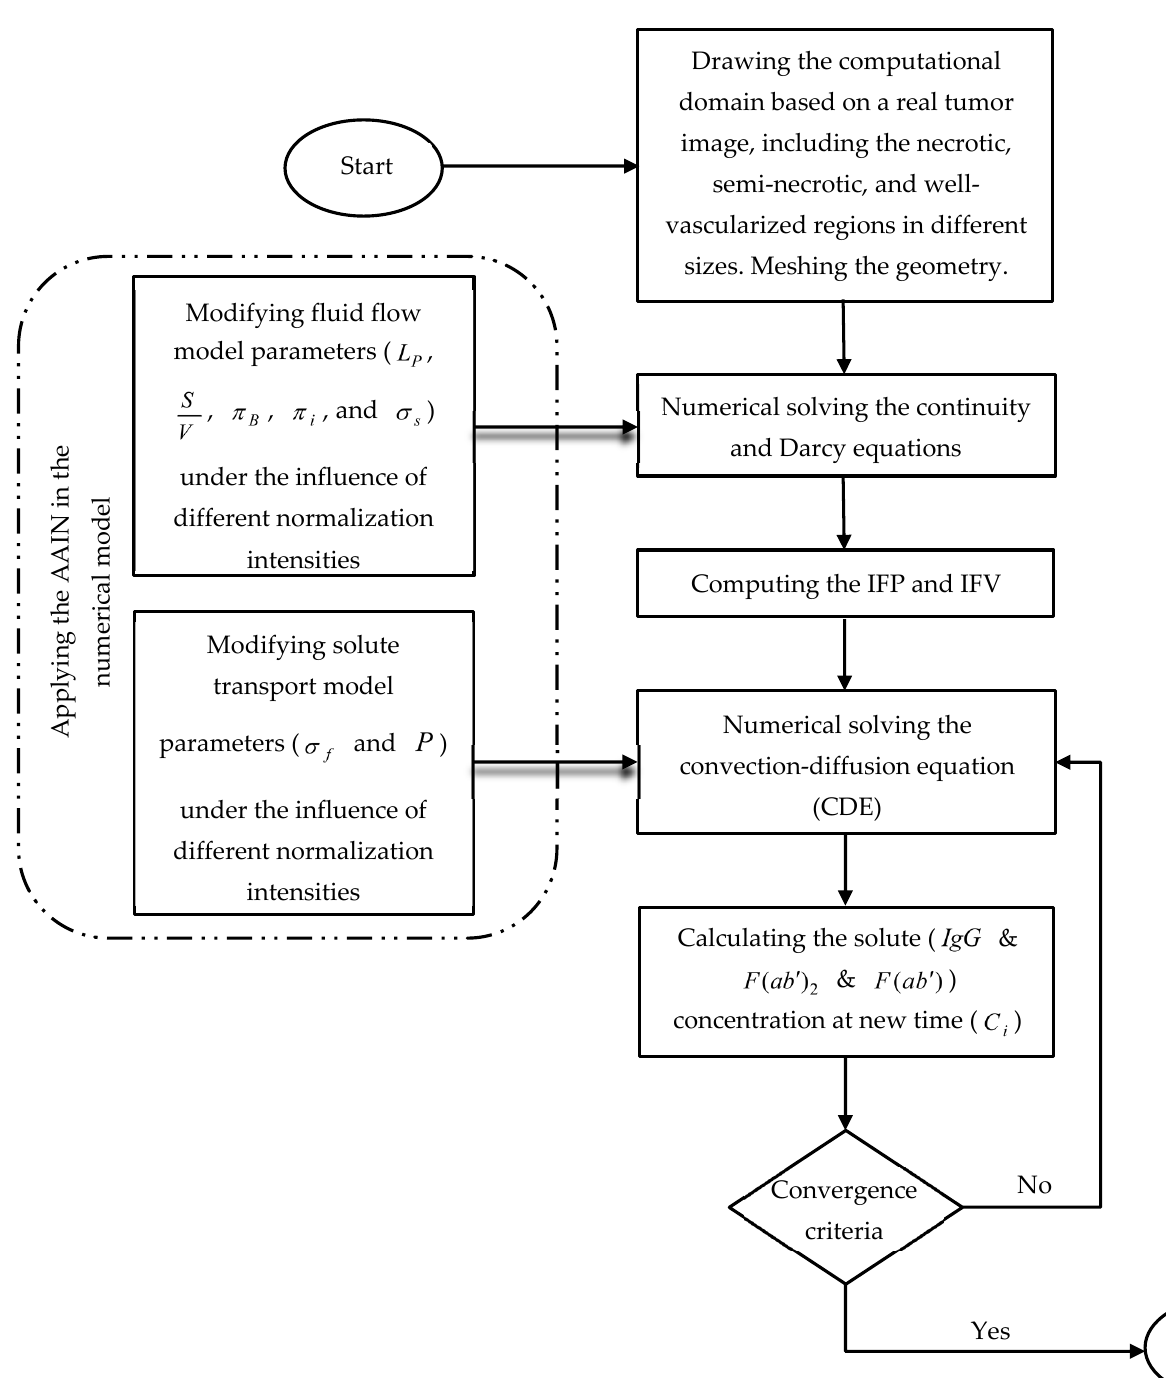
Figure 4. The flowchart of the numerical modeling procedure.